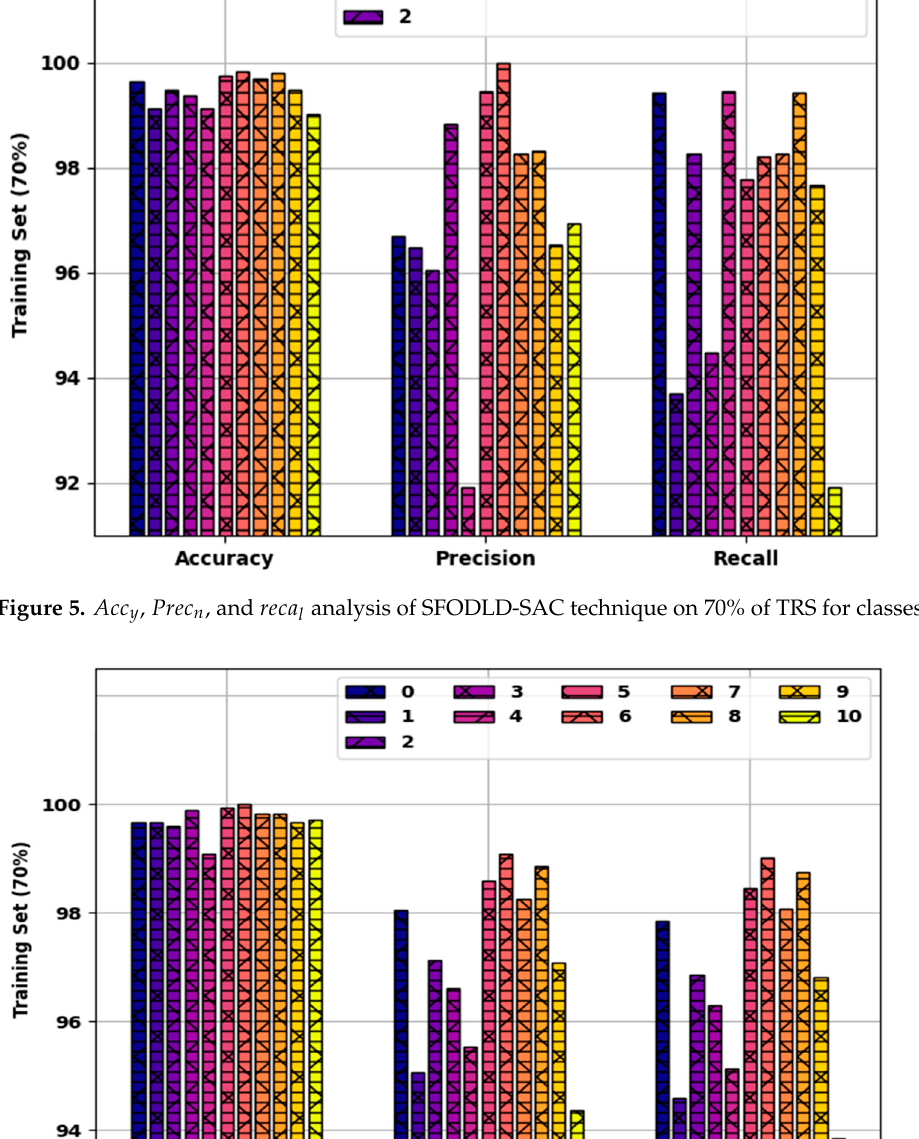
Figure 6. Spec y , F score , and MCC analysis of SFODLD-SAC technique on 70% of TRS for classes Figure 6. 𝑆𝑝𝑒𝑐 (cid:3052) , 𝐹 (cid:3046)(cid:3030)(cid:3042)(cid:3045)(cid:3032) , and 𝑀𝐶𝐶 analysis of SFODLD-SAC technique on 70% of TRS for classes 0–10.